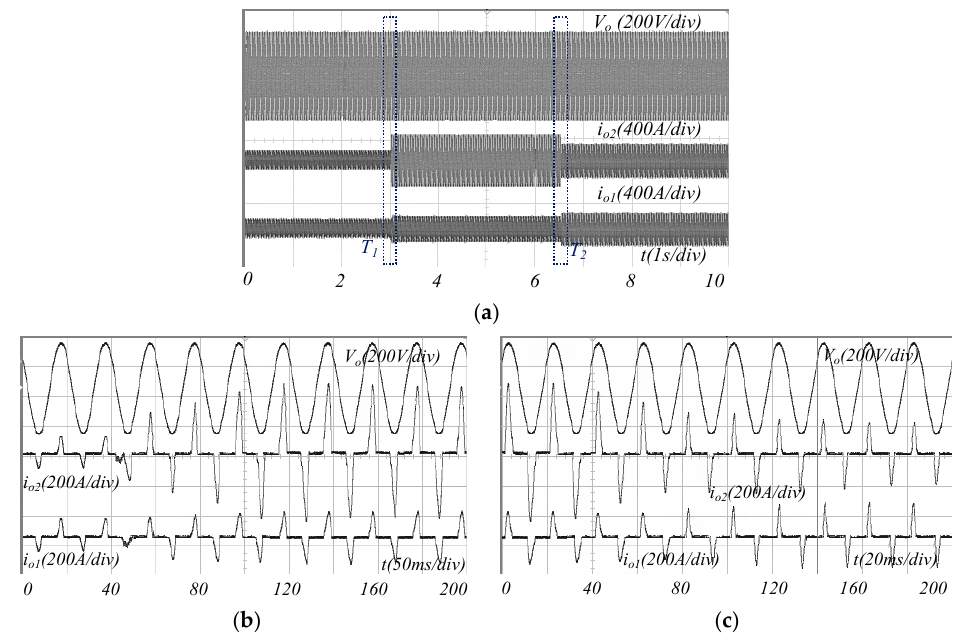
Figure 15. Current and voltage experimental waveforms of proposed method in experiment III: ( a ) in a long time scale; ( b ) during T 1 ; ( c ) during T 2 .